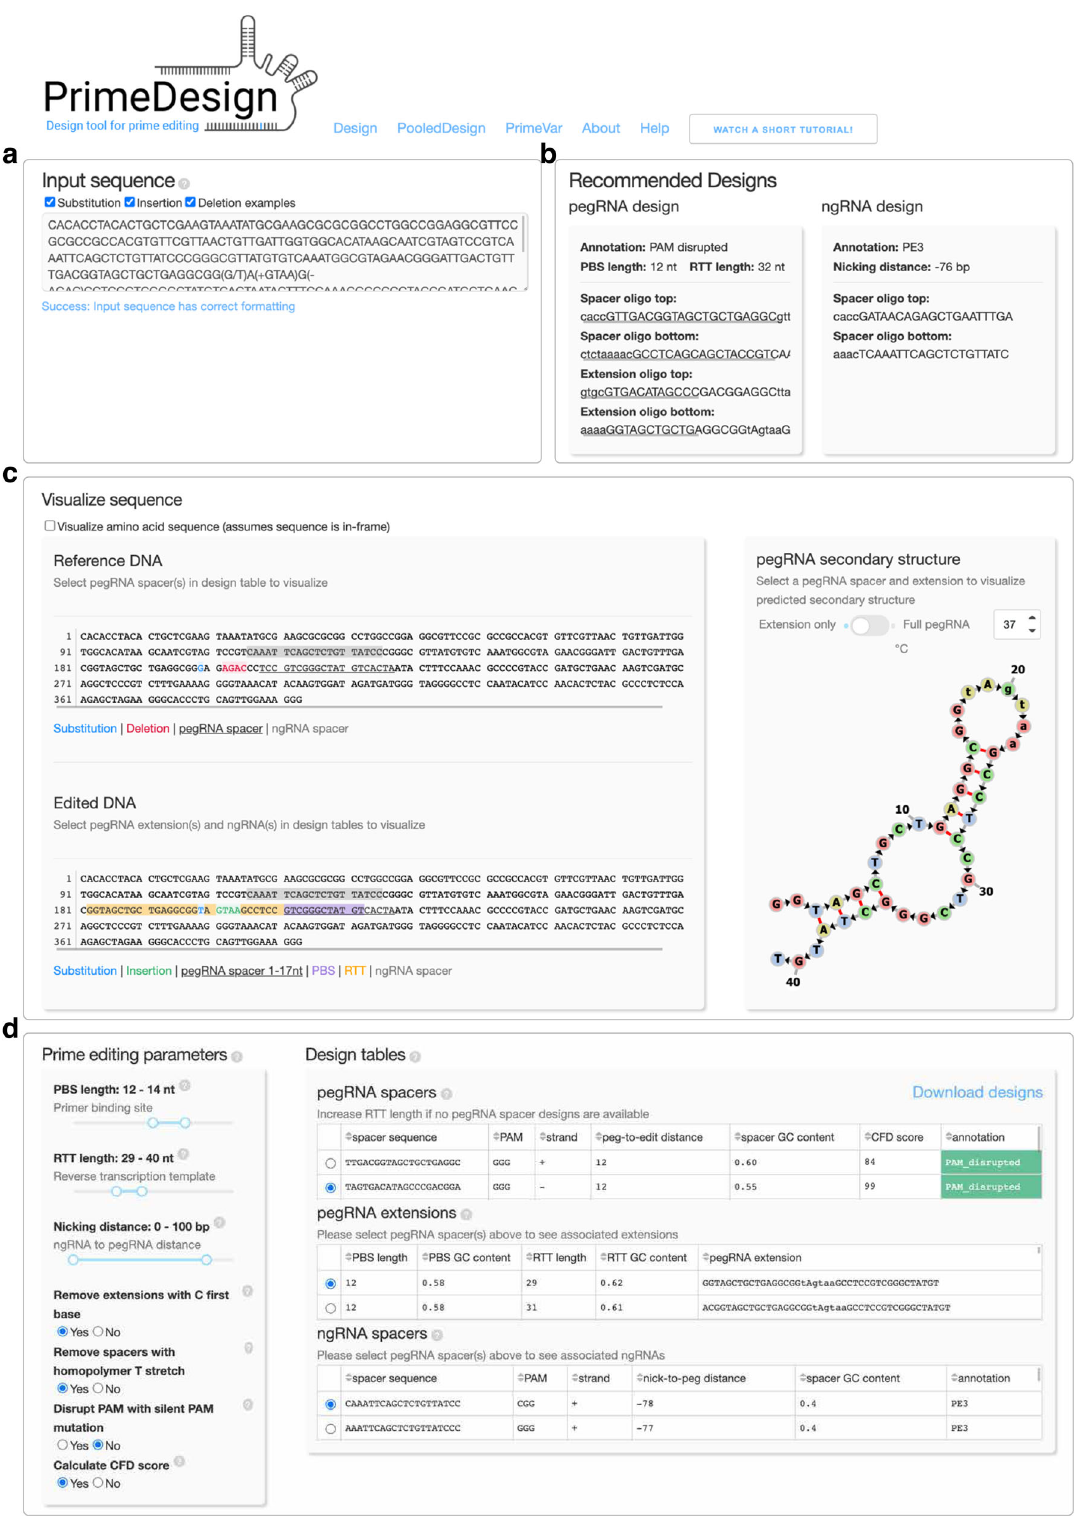
Fig. 1 PrimeDesign web application. a PrimeDesign takes a single sequence as input encoding both the original reference and desired edited sequences, b recommends a candidate pegRNA and ngRNA combination to install the edit of interest, c provides sequence visualizations of the edit of interest, selected pegRNA and ngRNA designs, and predicted pegRNA secondary structures, and d enables the interactive design of both pegRNAs and ngRNAs that can be downloaded as a summary table.